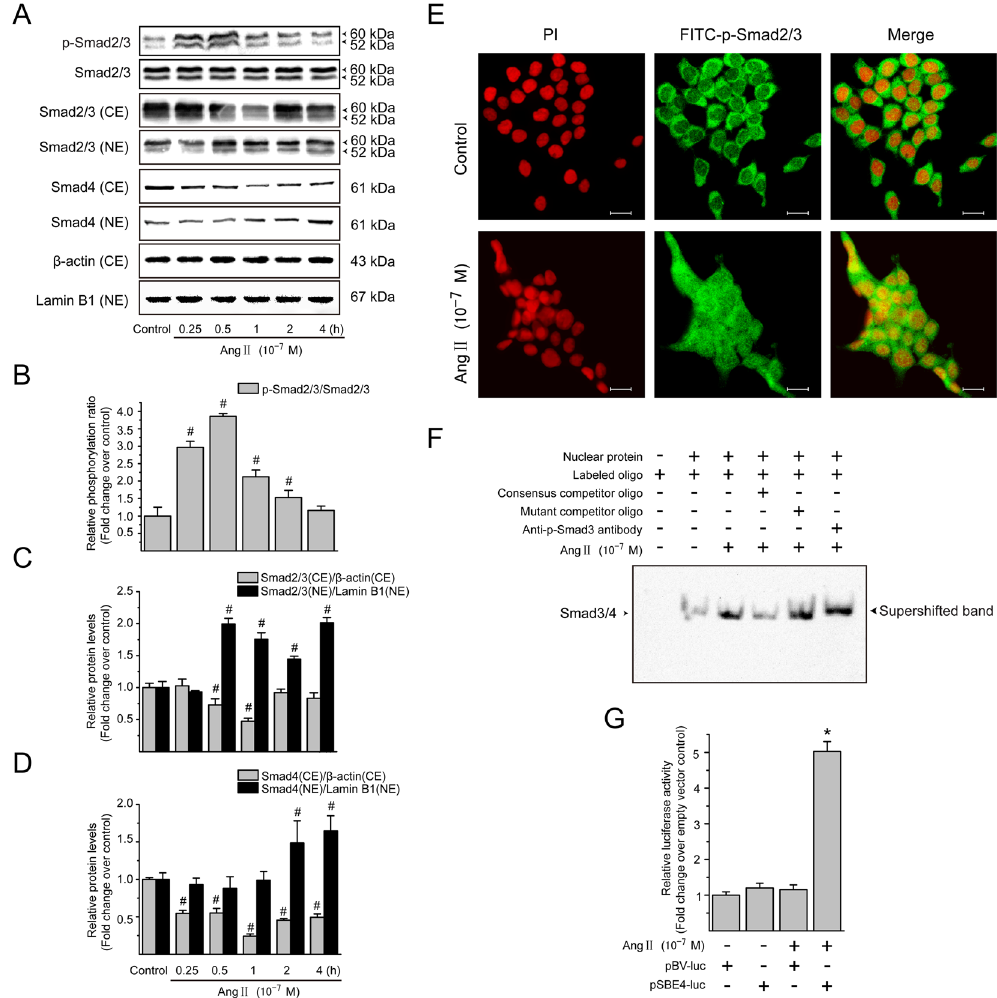
Figure 6. Ang II induces the Smad activation in LX-2 cells. ( A ) Serum-starved LX-2 cells were incubated with Ang II (10 − 7 M) for 0, 0.25, 0.5, 1, 2 and 4 h. Whole cell lysates were subjected to immunoblotting analysis using phosphorylated Smad2/3 antibodies, and total protein levels of Smad2/3 were used as internal controls. Cytoplasmic and nuclear fractions were prepared and analyzed by Western blotting to detect Smad2/3 and Smad4. The β -actin and lamin B1 protein levels were used as internal controls, respectively, for cytoplasmic extracts (CE) and nuclear extracts (NE). ( B–D ) The protein levels of phosphorylated Smad2/3 in whole cell extracts, and Smad2/3 and Smad4 in cytoplasmic and nuclear extracts were converted to arbitrary densitometric units, normalized by the value of the corresponding loading control and expressed relative to the phosphorylation ratio or the protein level as n -fold over unstimulated cells (defined as 1-fold). ( E ) The localization of phosphorylated Smad2/3 was examined by immunofluorescence staining following treatment of LX-2 cells with Ang II (10 − 7 M) for 0.5 h. The fluorescence images were observed and captured by a confocal laser scanning microscope. Scale bar, 20 μ m. ( F ) Serum-starved LX-2 cells were incubated with Ang II (10 − 7 M) for 0.5 h. Nuclear proteins were extracted and the binding activity of Smad3/4 with the consensus binding sequences was analyzed by EMSA, as described in Materials and Methods. The binding mixtures were separated on a 6% nondenaturing polyacrylamide and the DNA-protein complexes were visualized with an ECL assay Kit. ( G ) Serum-starved LX-2 were transfected with either Smad binding element-luciferase reporter plasmid (pSBE4-luc) or pBV-Luc reporter construct, and then stimulated by Ang II (10 − 7 M) for 0.5 h. The Renilla luciferase reporter plasmid was used as the internal control of transfection efficiency. The firefly or Renilla luciferase activity in total cell extracts was determined using the Dual-Luciferase Reporter Assay System. Experiments were repeated 3 times with similar results, and all data are presented as mean ± SD. # P < 0.05 versus unstimulated control cells; * P < 0.05 versus pSBE4-luc-transfected cells without Ang II